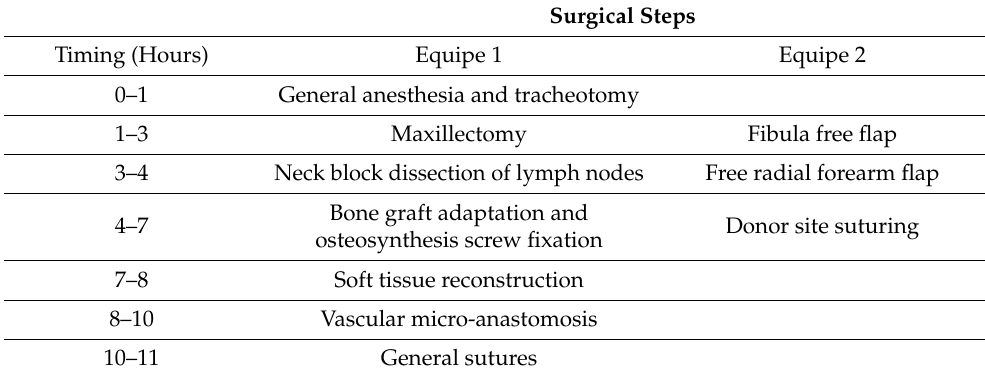
Table 1. Main surgical steps.